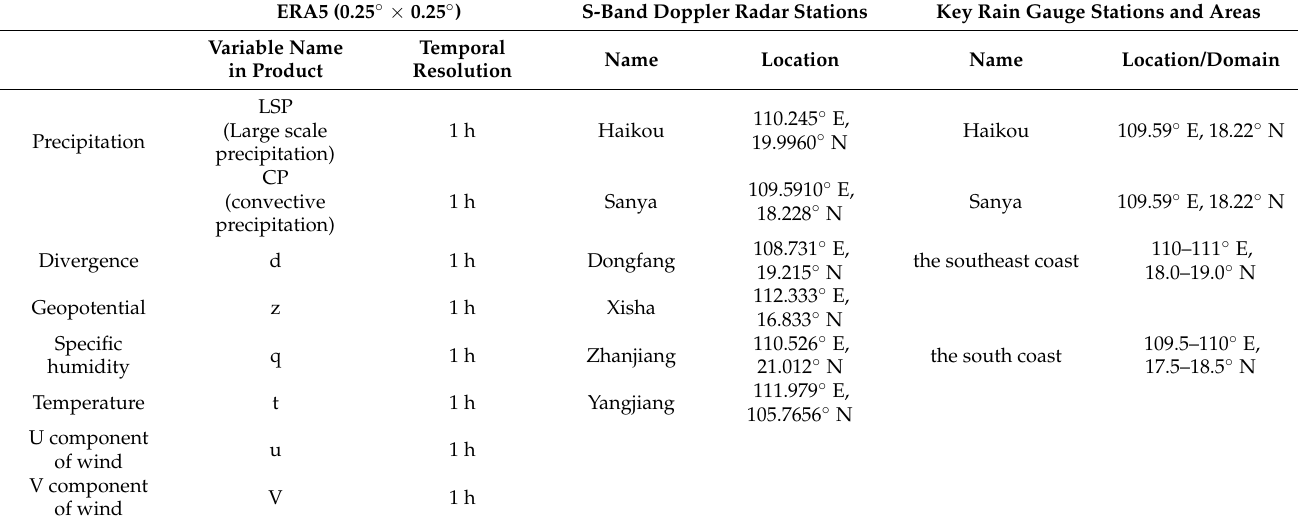
Table 1. Details of adopted ERA reanalysis data and surface observation